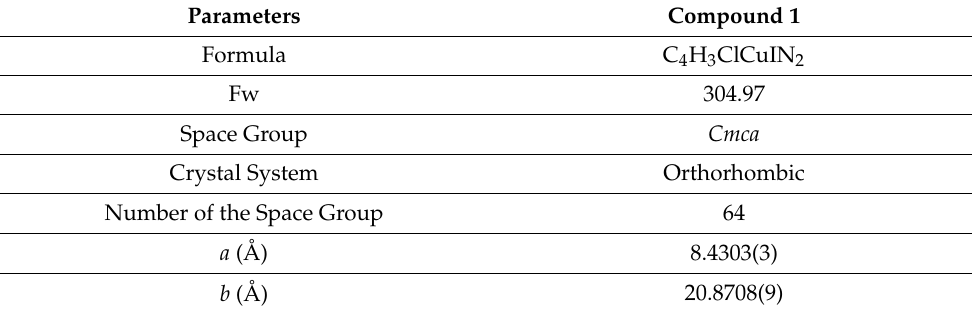
Table 1. X-ray diffraction data of compound 1